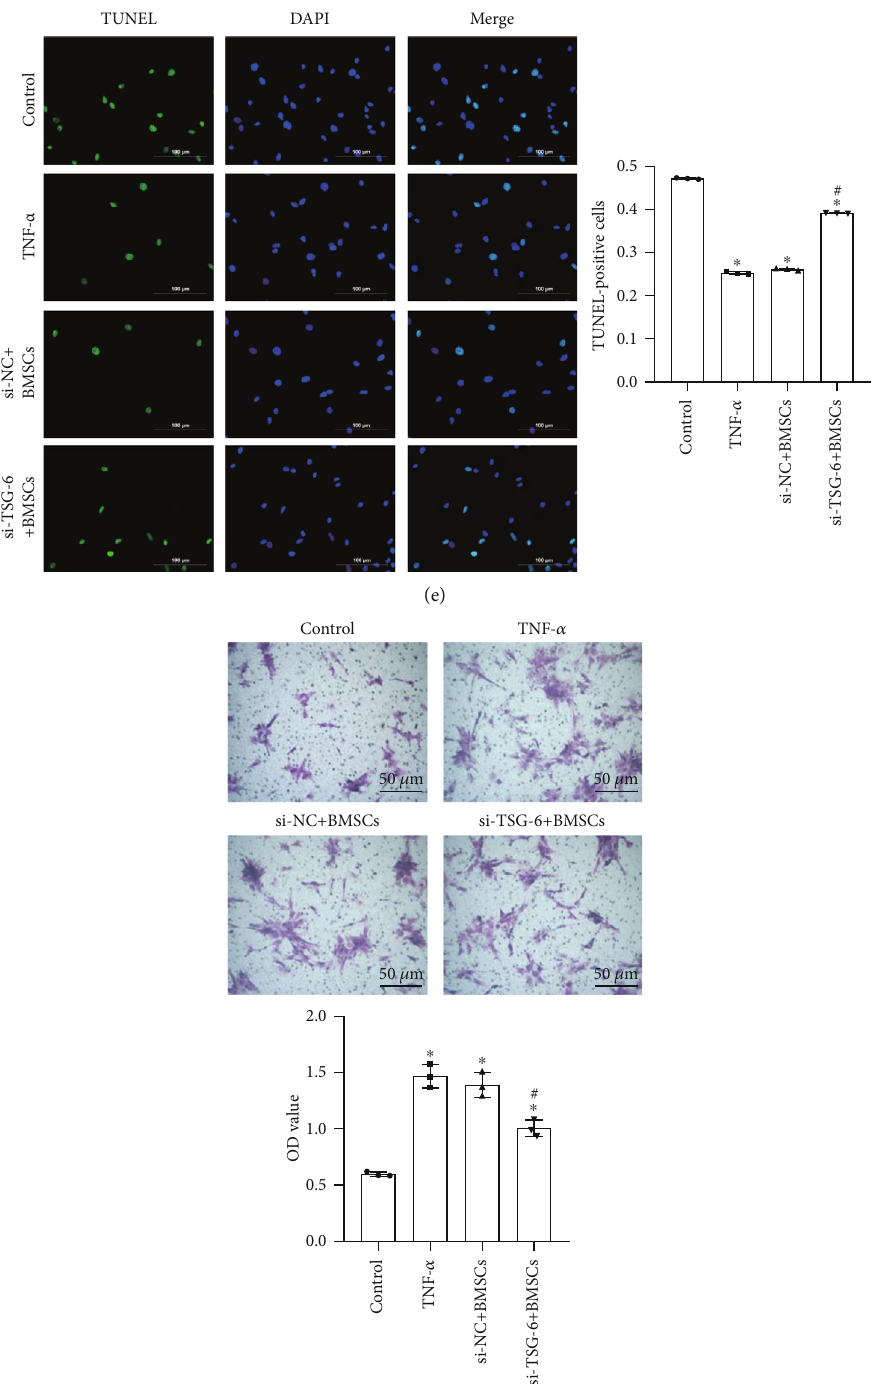
Figure 2: The e ff ect of TSG-6 secreted by BMSCs on activated astrocytes. (a) qRT-PCR was utilized to detect TSG-6 expression in BMSC cells. (b) Western blot analysis of the expression of TSG-6 in BMSC cells. (c) qRT-PCR was utilized to test the expression levels of occludin, claudin 3, ZO-1, and iNOS in activated astrocytes. (d) Western blot was used to measure the protein expression levels of occludin, claudin 3, ZO-1, and iNOS in astrocytes. (e) TUNEL assay was used to detect astrocyte apoptosis (scale bar, 100 μ m). (f) Invasion of astrocytes was examined by transwell assay (scale bar, 50 μ m). BMSCs (medium containing BMSCs (TNF- α activation group)), si − NC + BMSCs (medium containing BMSCs (NC siRNA + TNF − α activation group)), and si − TSG − 6 + BMSCs (medium containing BMSCs ( siRNA − TSG − 6 + TNF − α activation group)). ∗ Compared with the control group, P < 0 : 05 ; # compared with the si − NC + BMSC group, P < 0 : 05 . The above experimental results were all measurement data. Data were expressed as the mean ± SD . One-way ANOVA and Tukey ’ s test were used only for the data comparison between multiple